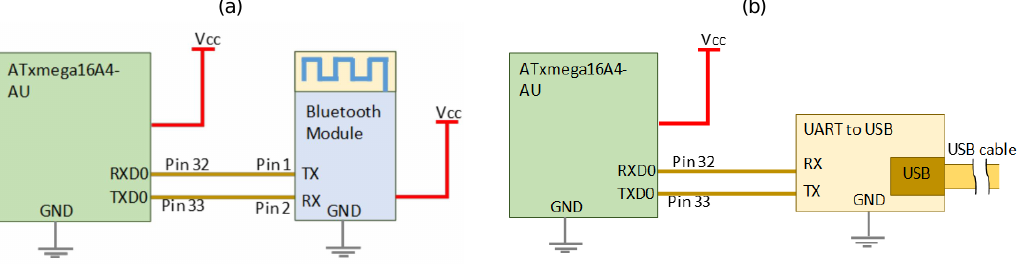
Figure 2. LUME-20R Bluetooth connection ( a ) and wire connection for USB communication ( b